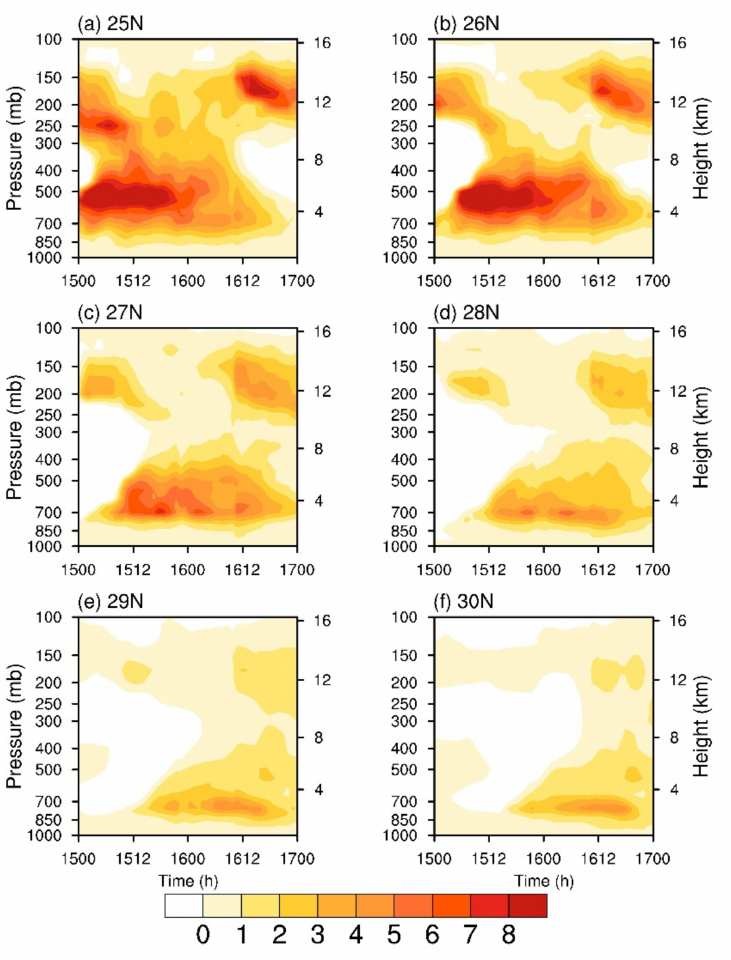
Figure 7. Variation in the abnormal magnification of water vapor transport in the C area at 25–30 ◦ N with time from 0:00 on the 15 September to 0:00 on the 17 September. ( a ) 25 ◦ N, ( b ) 26 ◦ N, ( c ) 27 ◦ N, ( d ) 28 ◦ N, ( e ) 29 ◦ N and ( f ) 30 ◦